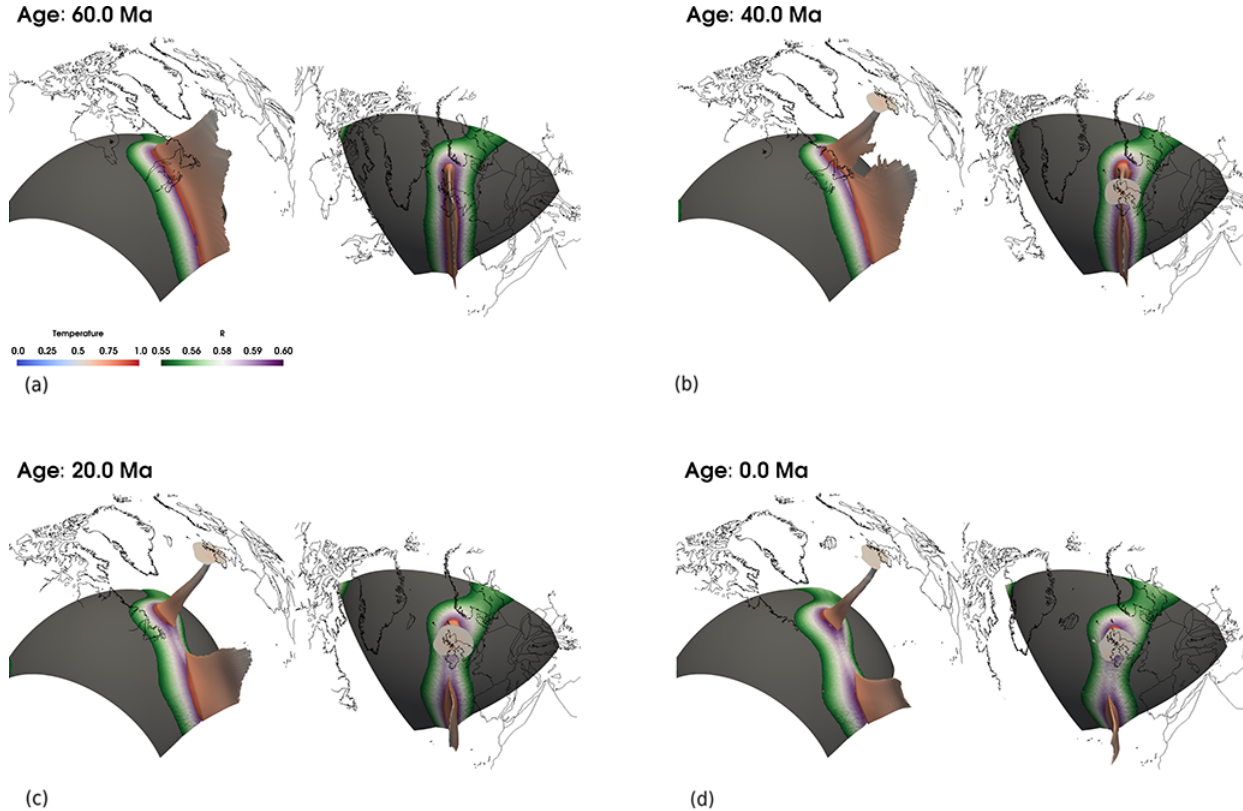
Figure 4. Same as Fig. 3 but for ages (a) 60Ma, (b) 40Ma, (c) 20Ma, and (d) 0Ma.